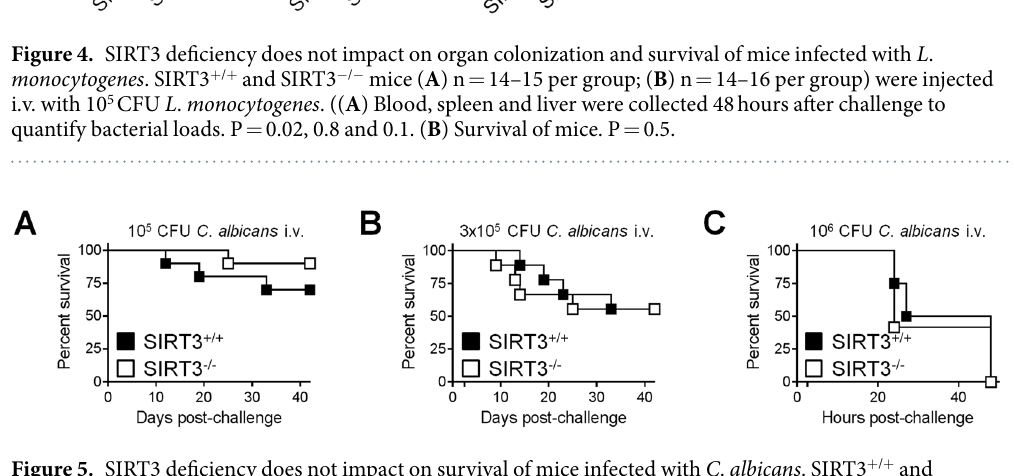
Figure 5. SIRT3 deficiency does not impact on survival of mice infected with C . albicans . SIRT3 + / + and SIRT3 − / − mice were injected i.v. with 10 5 ( A ) n = 10 per group), 3 × 10 5 ( B ) n = 9 per group) and 10 6 CFU C . albicans ( C ) n = 12 per group). ( A – C ) Survival of mice. P = 0.3, 0.8 and